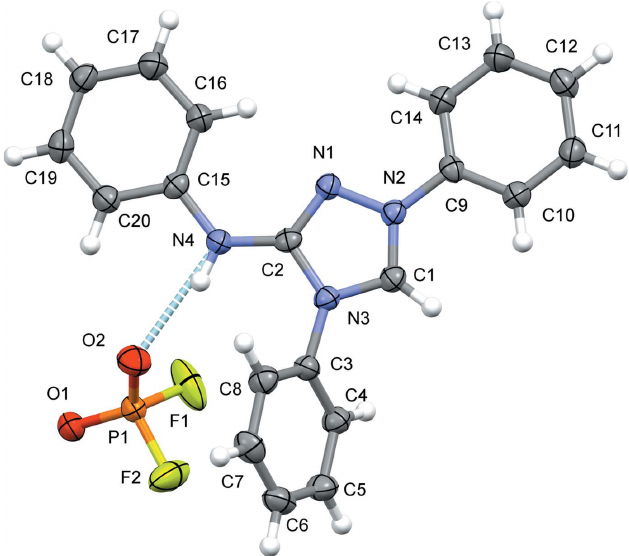
Figure 2 The asymmetric unit of III , showing the molecular components with displacement ellipsoids for non-H atoms drawn at the 75% probability level. H atoms are given as spheres of arbitrary radius; N—H (cid:3)(cid:3)(cid:3) O hydrogen bonding between the organic cation and the inorganic anion is shown as a light-blue dashed line.